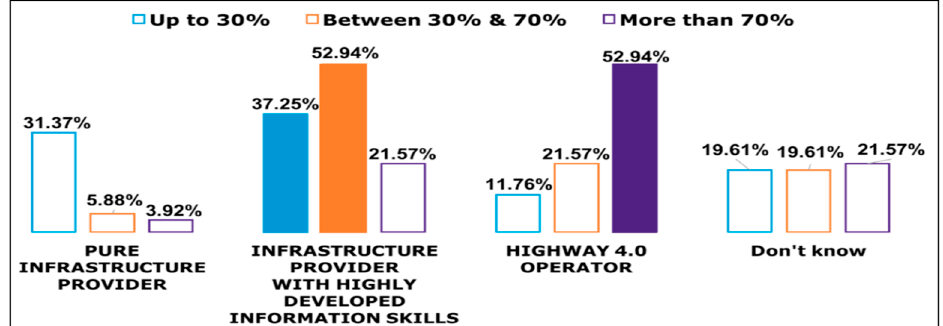
Figure 4. Potential business transformations.